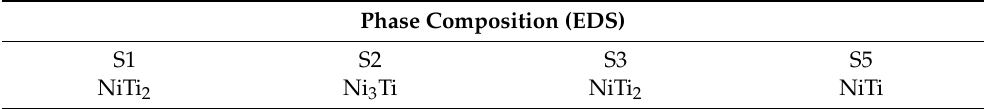
Figure 4. Micrographies of 3D object from filament A. ( a ) after sintering (SEM), ( b ) selected zones for evaluation of Ni:Ti ratio (S1, S2, S3 and S5) by SEM/EDS. Table 6. 3D object phases from filament A after sintering (Spectra(S) 1, 2, 3, and 5 in Figure 4b).